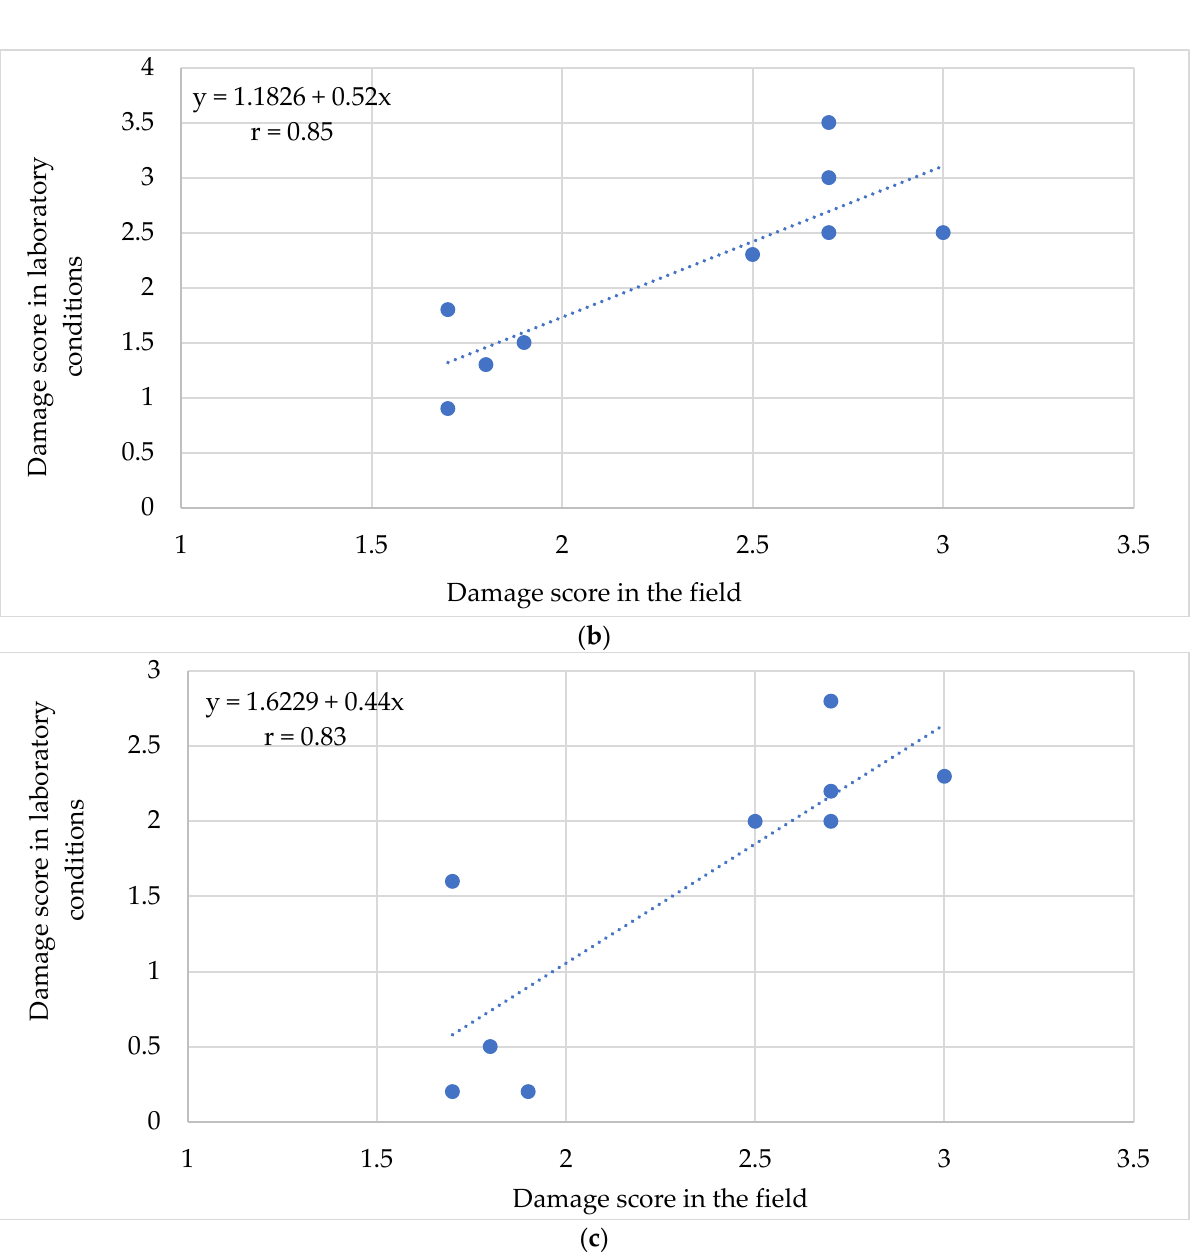
Figure 1. The relationship between the results of artificial freezing and field assessment of winter hardiness. ( a )—the second winter hardiness component). ( b )—the third winter hardiness component). ( c )—the fourth winter hardiness component).